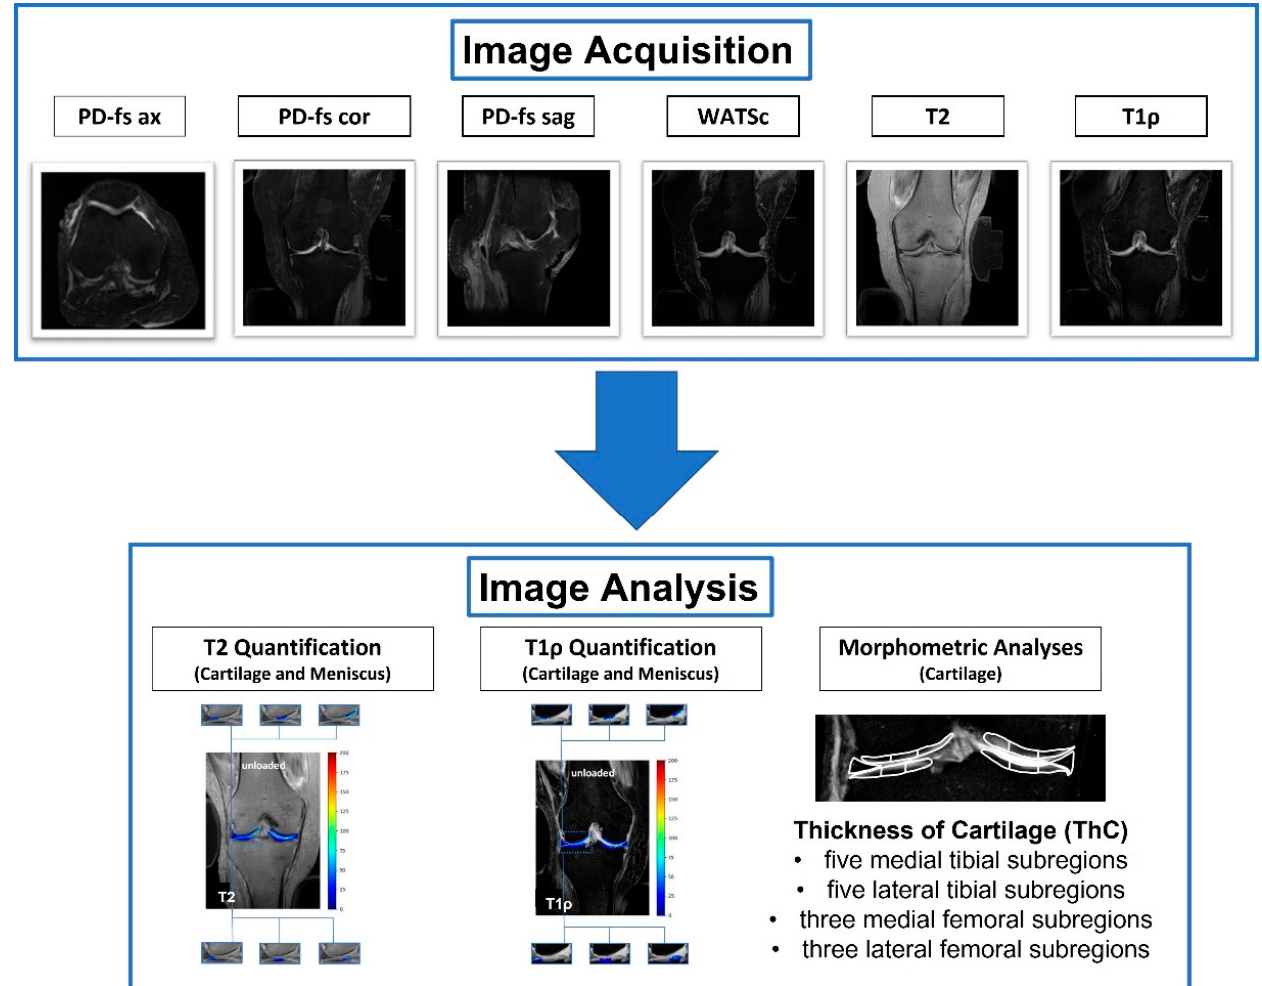
Figure A1. Loading unit of the MRI-compatible pressure-controlled loading device. ( a ) Schematic visualization of the components. (1) Pneumatic mechanism, (2) padded pressure applicator, (3) safety rails, (4) encasement, (5) pressure port,